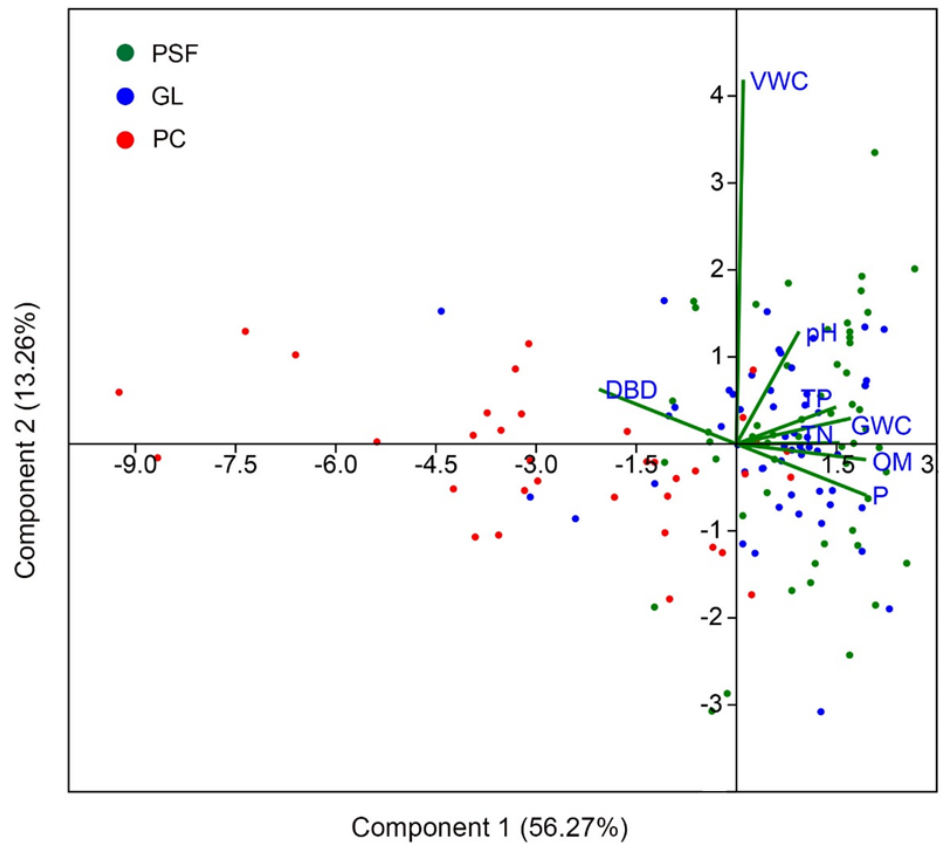
Figure 6. Principal Component Analysis (PCA) biplot showing the relationships between peat soil physicochemical properties and land use conversion classes. PSF=peat swamp forest, GL=grassland, PC=cultivation, GWC=gravimetric water content, VWC=volumetric water content, DBD=dry bulk density, P=total porosity, OM=organic matter, TN=total nitrogen, TP=total